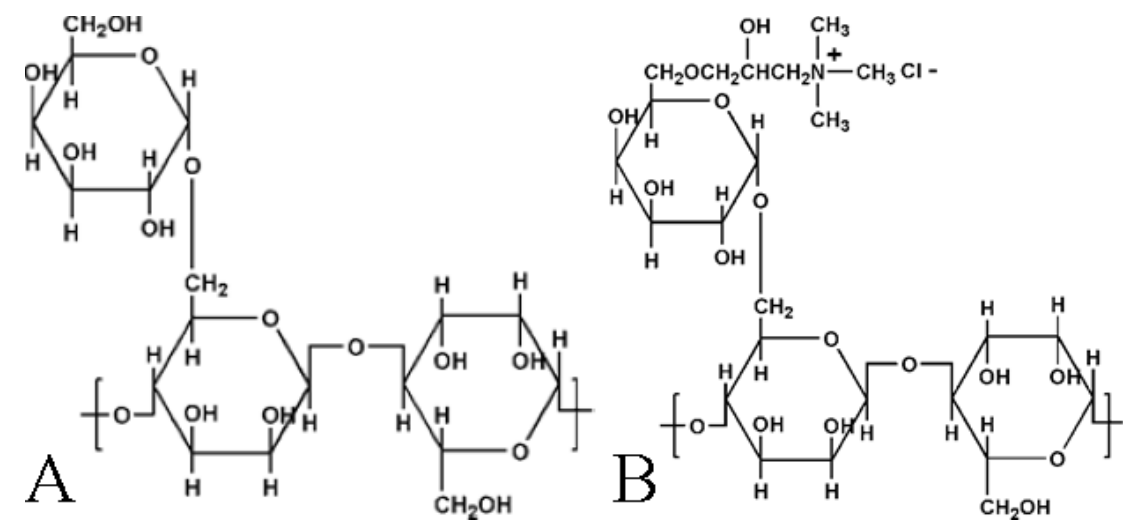
Figure 1. Structure of ( A ) Neutral guar gum (NG); and ( B ) Cationic guar gum